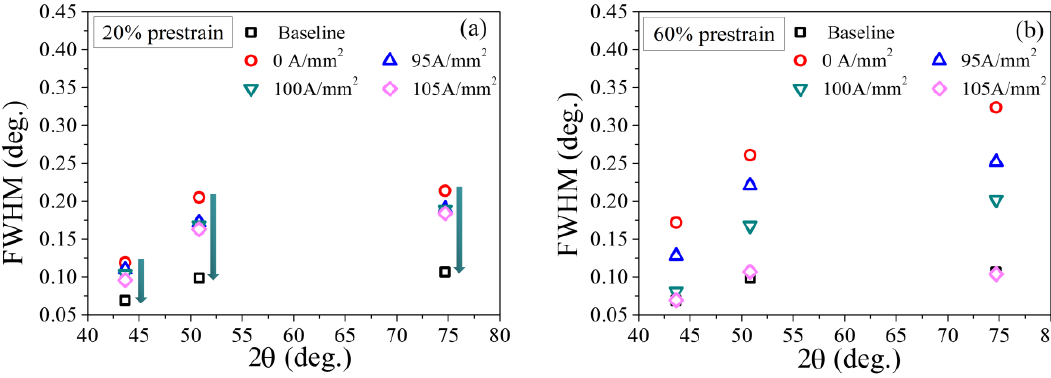
Figure 8. Full width at half maximum (FWHM) profiles of specimens with ( a ) 20% prestrain and ( b ) 60% prestrain.